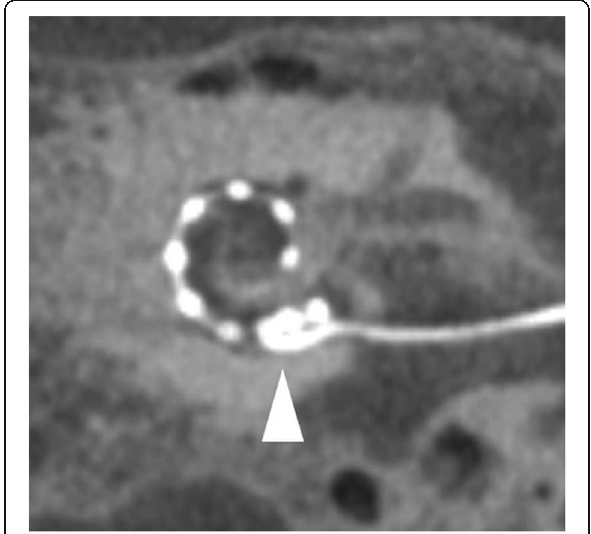
Fig. 29 A 66-year-old male patient, with tip fold-over. CBCT paraaxial maximum intensity projection image shows fold-over of the tip of the electrode in the cochlea (arrow)